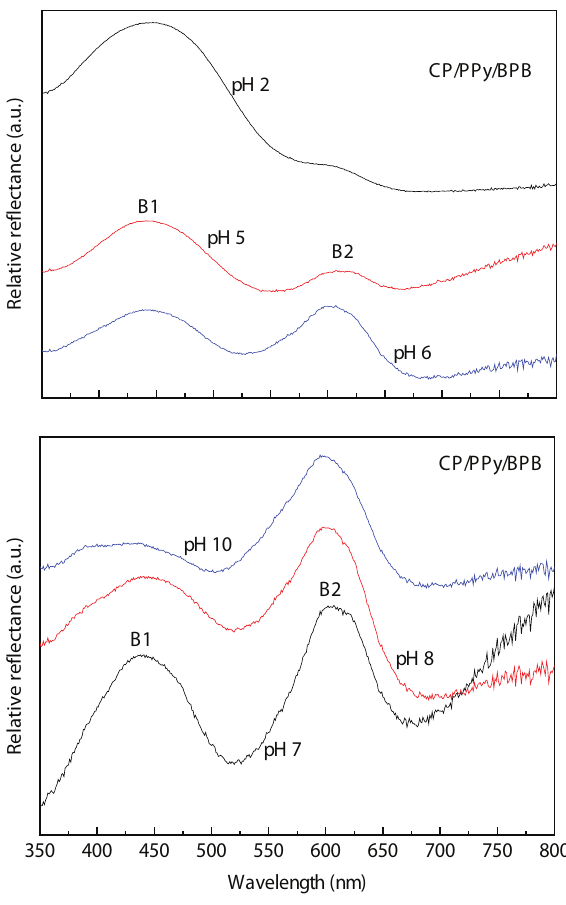
Figure 6: DRS curves for CP/PPy/BPB at different